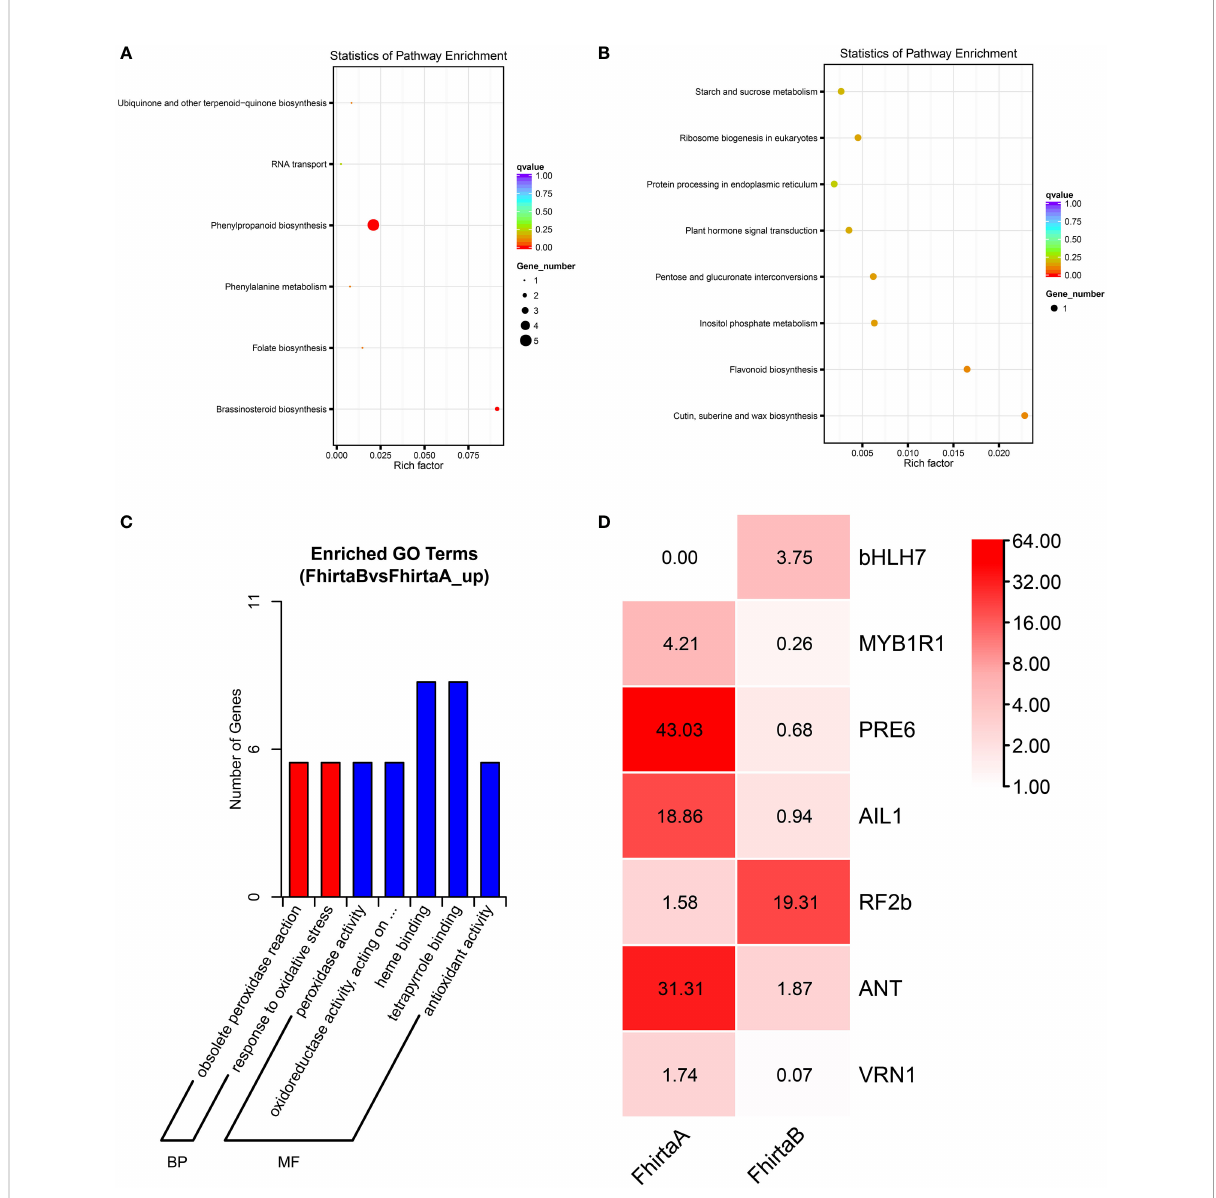
FIGURE 1 Kyoto Encyclopedia of Genes and Genomes (KEGG) and Gene Ontology (GO) enrichment analysis of differentially expressed genes (DEGs) between A- and B-phase of F hirta bracts. (A) KEGG classi fi cation pathway of up-regulated genes. (B) KEGG pathway of down-regulated genes. (C) GO classi fi cation of up-regulated genes. (D) Heatmaps of expression pro fi les of differentially expressed transcription factors genes according to FPKM. The data inside the box represents FPKM. FhirtaA and FhirtaB represent A phase and B phase of F hirta bracts,